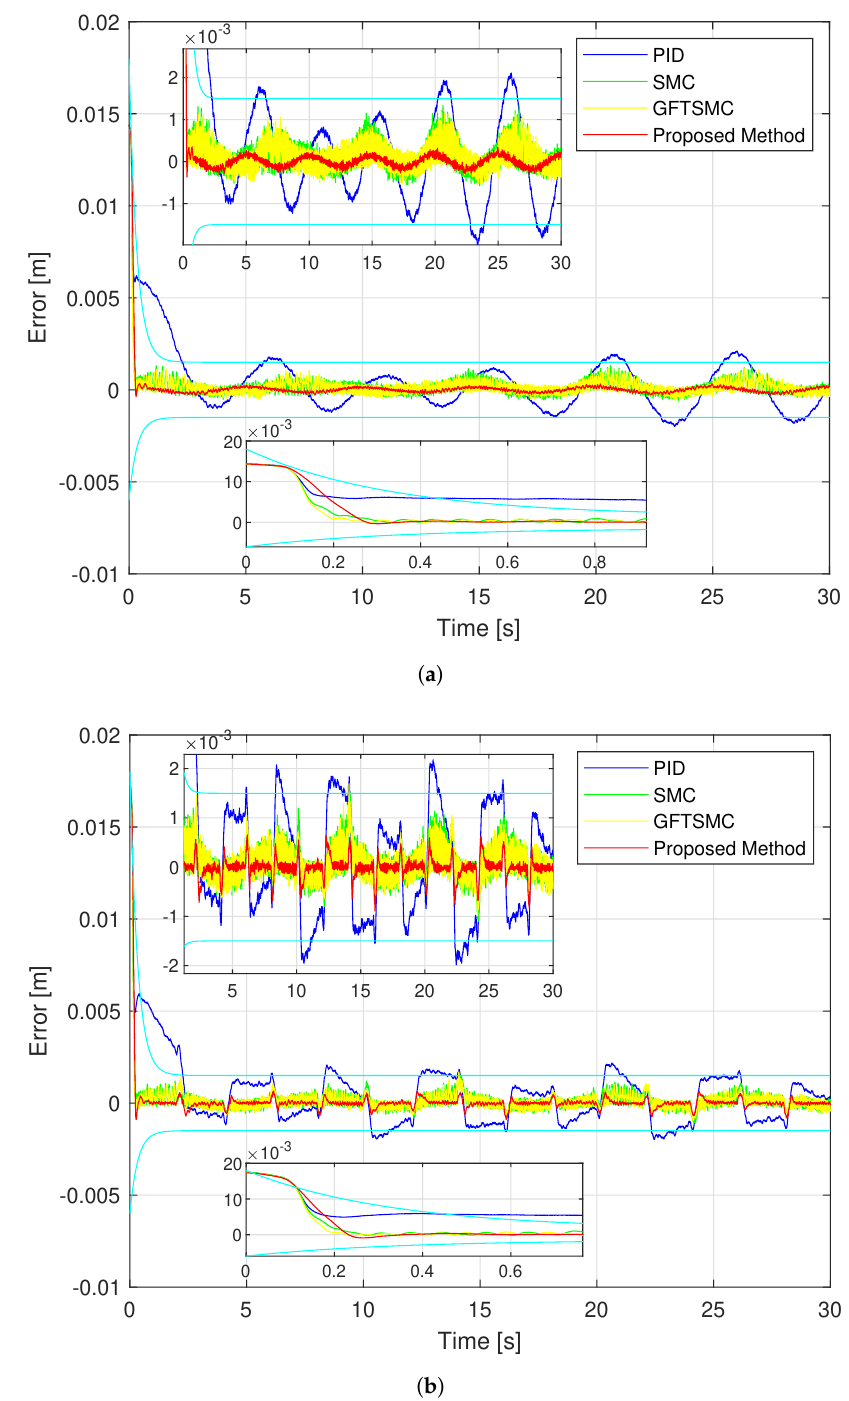
Figure 12. The trajectory errors of the controlled ball under four controllers; ( a ) in case of sinusoidal orbit; ( b ) in case of a rest-to-rest